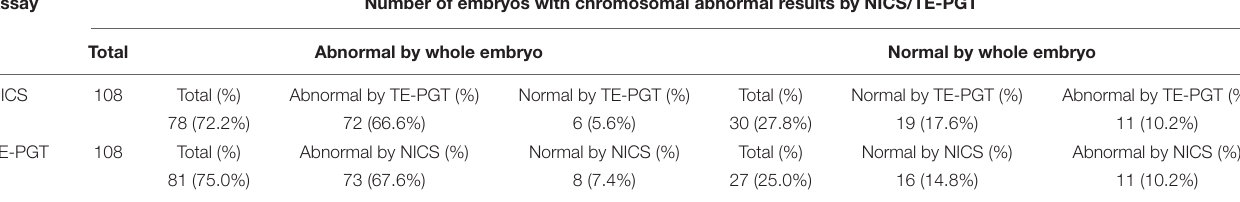
TABLE 6 | Characteristics of embryos with results of chromosomal abnormalities (group B) obtained from NICS or TE-PGT assay. Assay Total Abnormal by whole embryo Abnormal by TE-PGT (%) Normal by TE-PGT (%) Total (%) Normal by TE-PGT